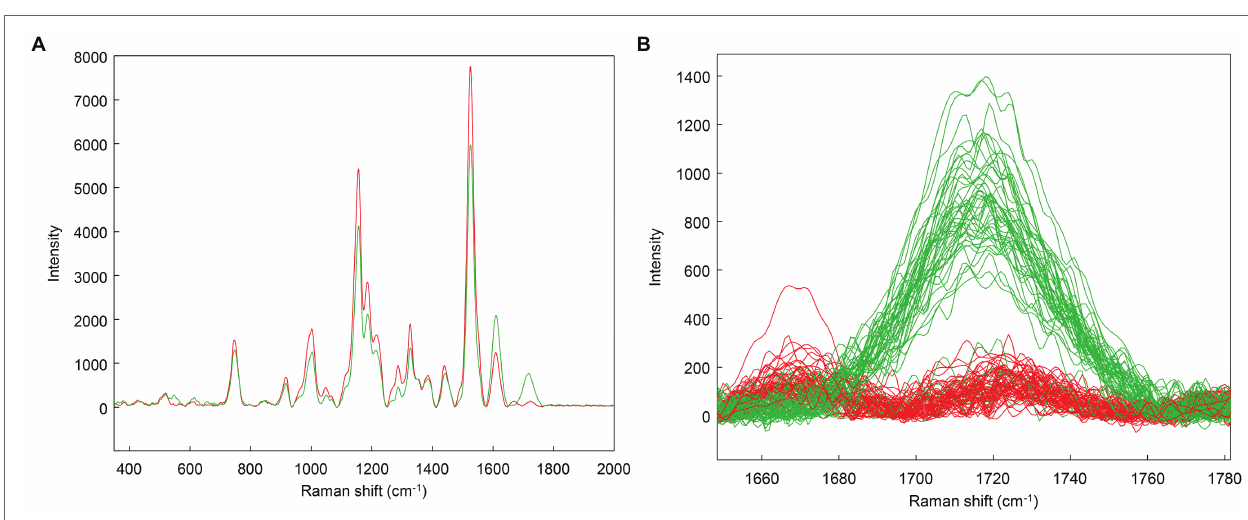
FIGURE 6 | Clustering on the asymptomatic (AS) class only. Spectral averages (A) and zoom of the 1720 cm − 1 region with individual spectra (B)